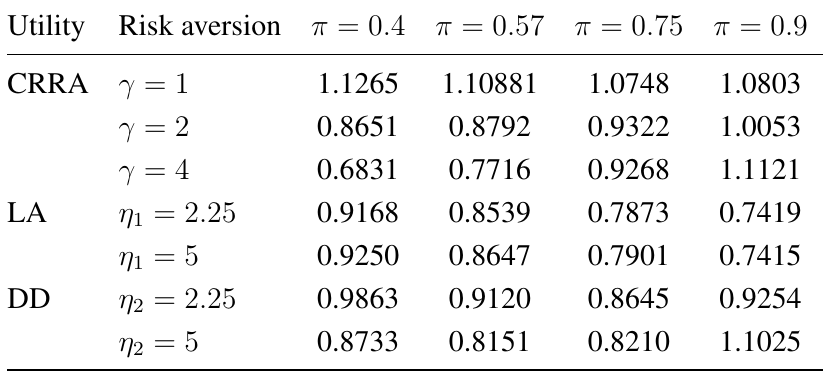
for λ = 0 . 25 CE DC